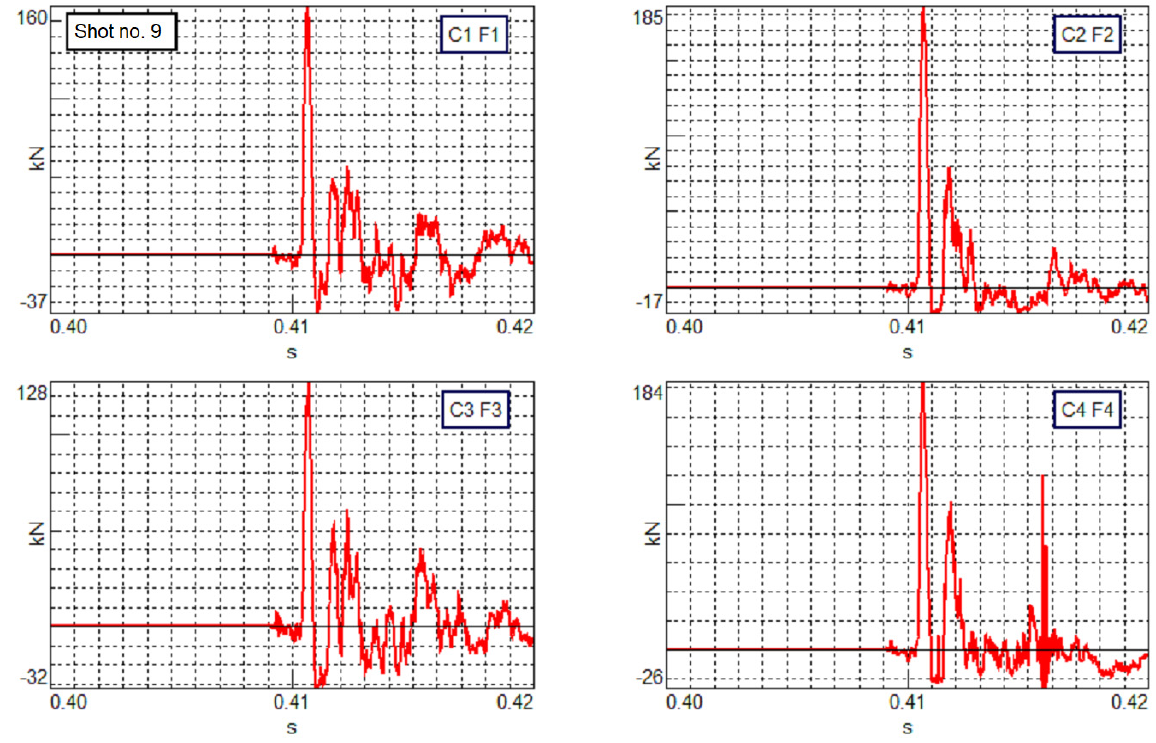
Figure 19. Forces recorded by 4 load sensors (shot no. 9).